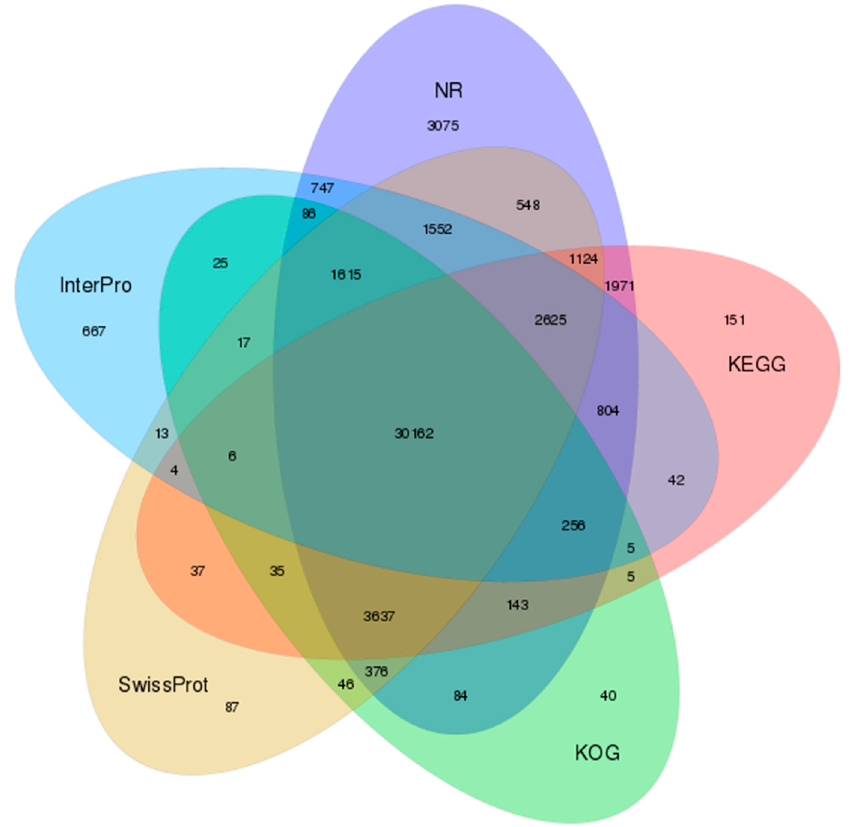
Figure 3. Venn diagram of shared and unique unigenes in Scutiger cf. sikimmensis among the five most informative databases used for annotation. GO = gene orthology; InterPro = integrative protein signature database; KEGG = Kyoto Encyclopedia of Genes and Genomes; KOG = EuKaryotic Orthologous Groups; NR = non-redundant protein database; NT = non-redundant nucleotide database; SwissProt = Swiss Protein Sequence Database.